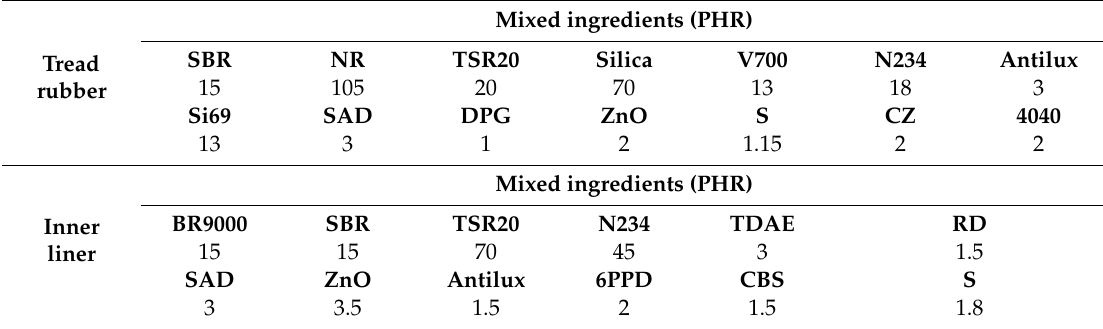
Table 1. Formulation of the test